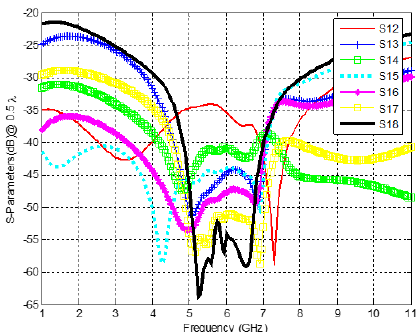
FIGURE 11. Parametric study of the broadband mutual coupling for different values of inter-element distance (0.5 λ ) (4 antennas array)